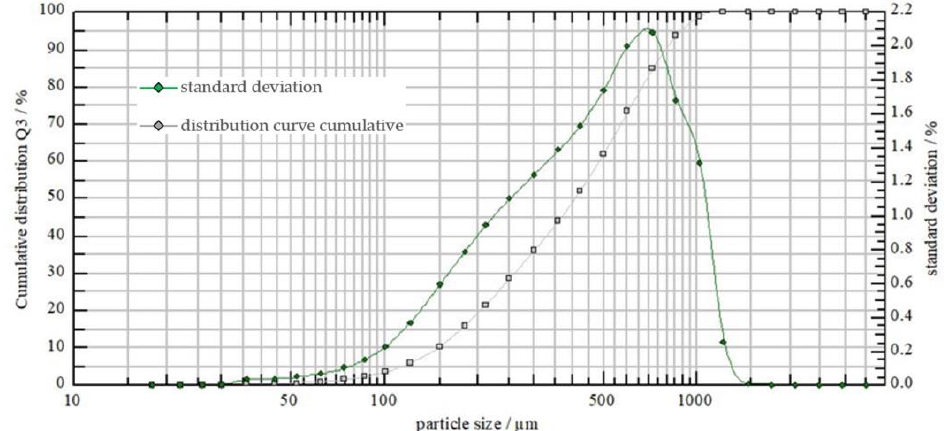
Figure 4. 6MS03C sprayer’s droplet spectrum at a pressure of 0.40 MPa.